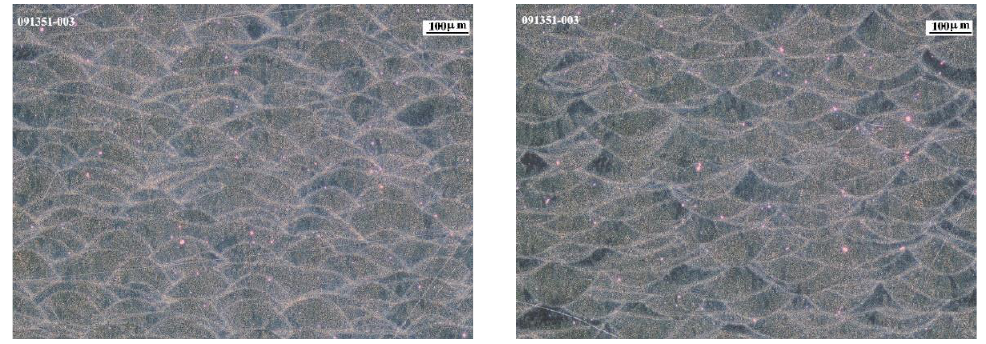
Figure 9. Microstructure on the XZ ( left ) and YZ ( right ) planes (×100). In the plane XY, a different pattern can be observed (Figure 10). This is more related to the welding path along the laser beam movement on the upper surface of the sample (diagonally interlaced).